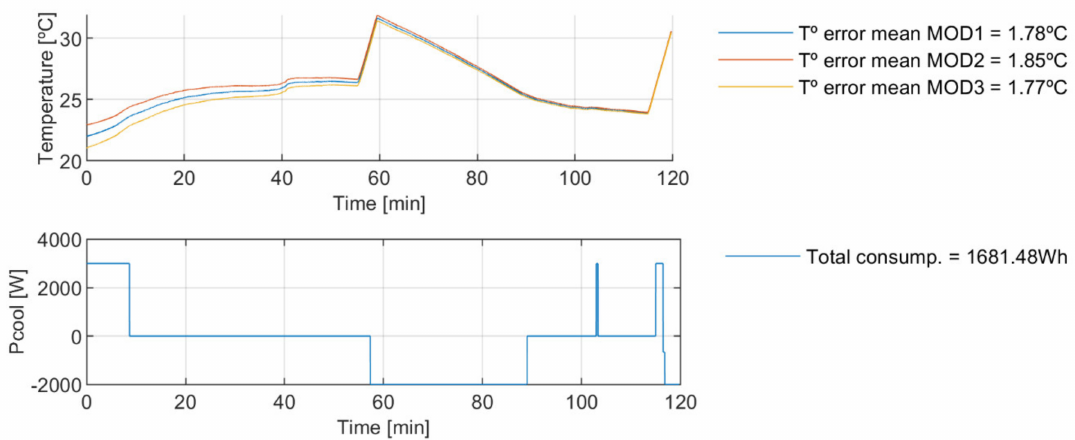
Figure 14. Use case simulation with the developed SVM based